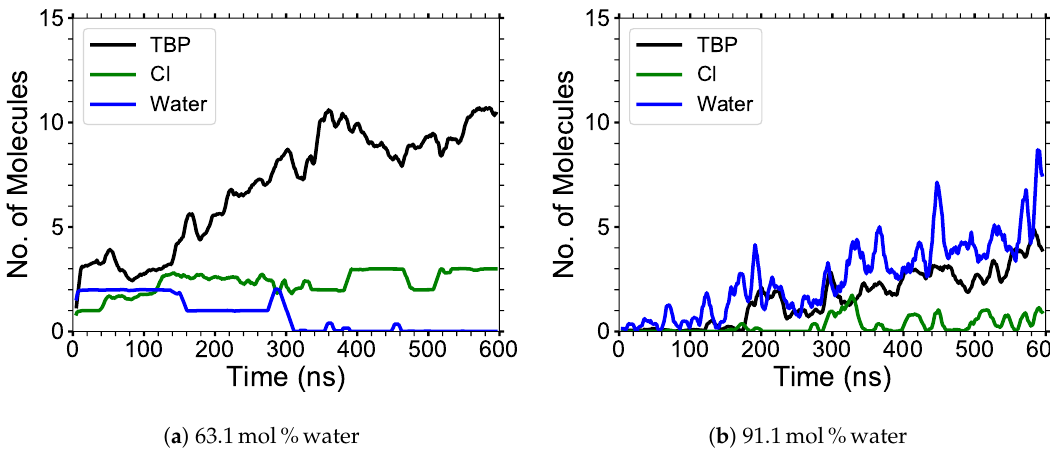
Figure A22. The number of molecules between the first yellow peeling strand and the cellulose bundle at various concentrations: ( a ) 63.1mol%water ; ( b ) 91.1mol%water. The water, TBP, and Cl molecules are counted if they are within 3.5Å of the 10 inner glycans of the light pink interior cellulose strand (see Figure 4). The data were averaged over 1000 data points, using a rolling